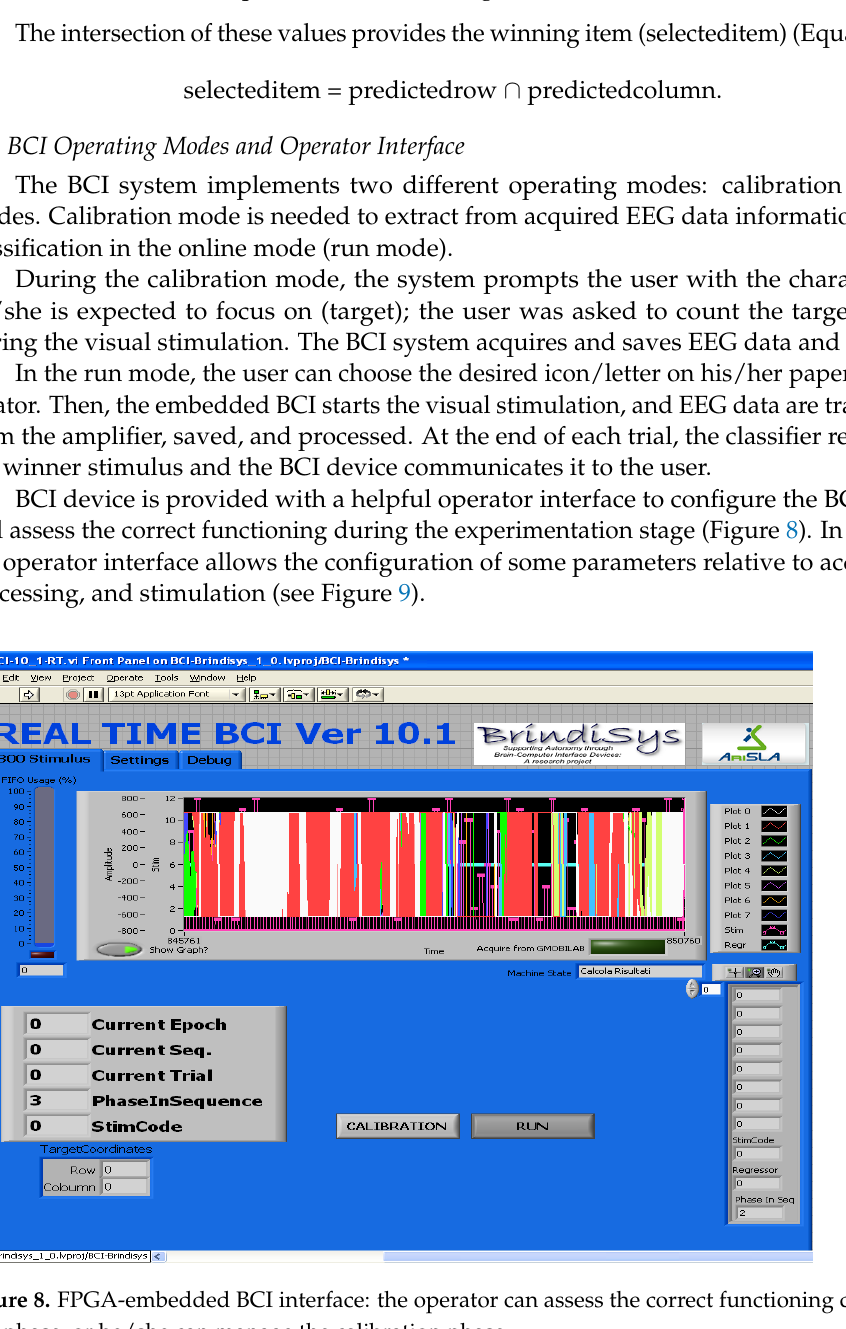
Figure 9. Operator interface of FPGA-embedded BCI that allows the configuration of the system. 3. Results The system was initially tested on a healthy subject to verify the correct operation and evaluate its performance. The alphanumeric communicator has been overlaid on the stimulation panel to allow the user to perform a communication task. The subject was seated facing the stimulation panel (see Figure 10).